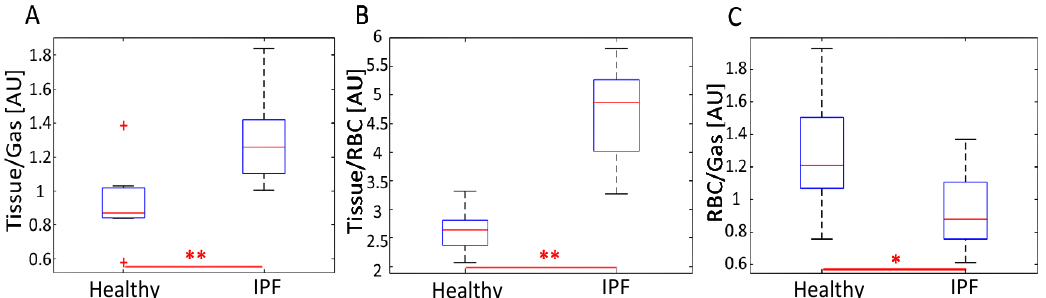
Figure 2. Coronal maps of ventilation and 3D-SBCSI Tissue/RBC, Tissue/Gas, and RBC/Gas in ( A ) healthy subject H4 and ( B ) IPF subject I8.